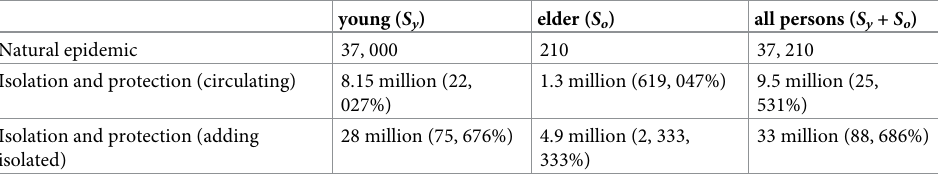
Table 4. The numbers of susceptible persons S and S tot ¼ S tot þ S tot at the end of the first wave of the epidemic. The percentage between parentheses is the ratio y o between with and without interventions S ( k , ε )/ S (0,